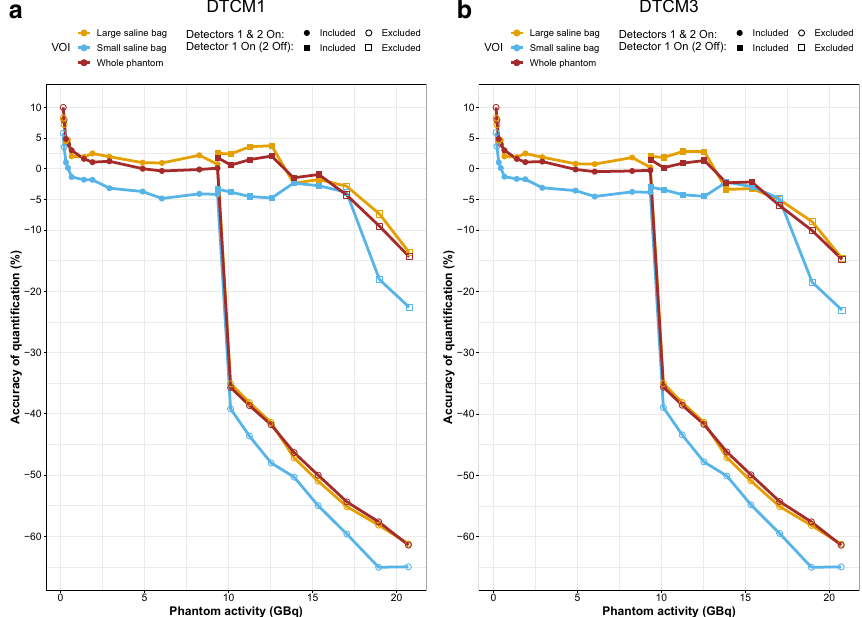
Fig. 2 Phantom SPECT quantification errors with both detectors activated (circular points) and only detector 1 activated (detector 2 off, square points) following dead‑time correction with DTCM1 ( a ) and DTCM3 ( b ). Hollow data points belong to excluded datasets for which quantification inaccuracies of more than 5% were observed, because of either very low activity or detector